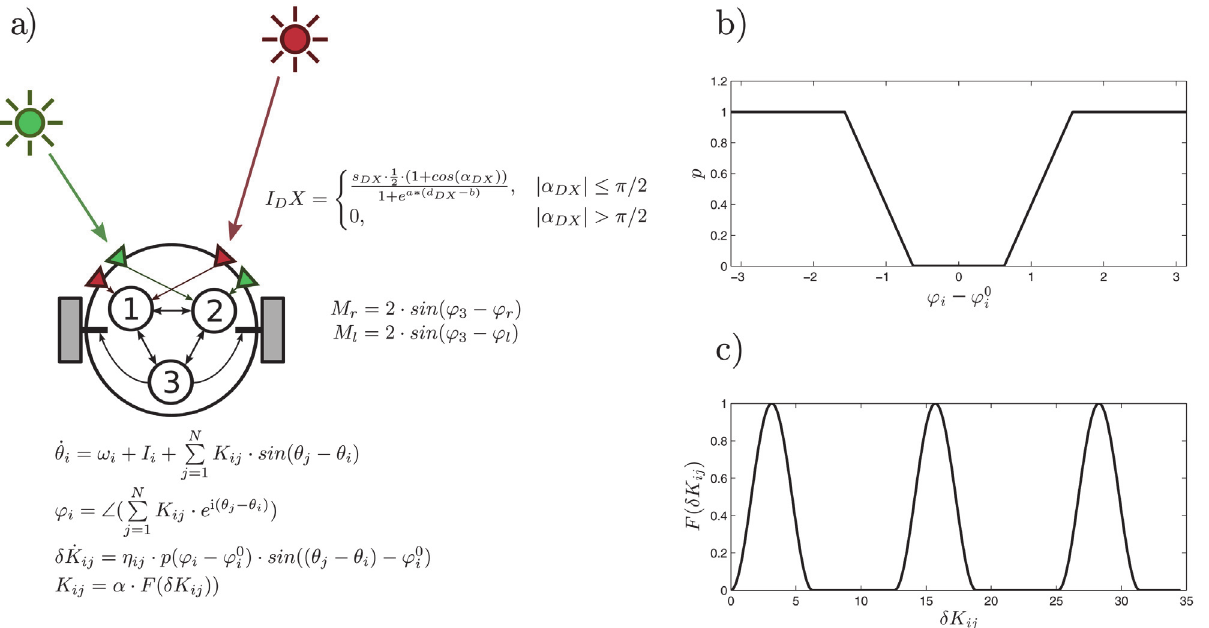
Fig 1. The robotic agent with three plastic oscillatory units. a) Scheme of the agent, the environment, sensors and motors, and the neural controller b) Plastic function p ð φ i (cid:3) φ 0 i Þ , in which plasticity depends on the difference between the weighted phase relation φ i of the neural oscillator i with respect to other oscillators and the preferred weighted phase relation φ 0 i c) Mapping function F ( δ K ij ) which transforms weight values δ K ij into the actual value of coupling strengths between oscillators K ij .